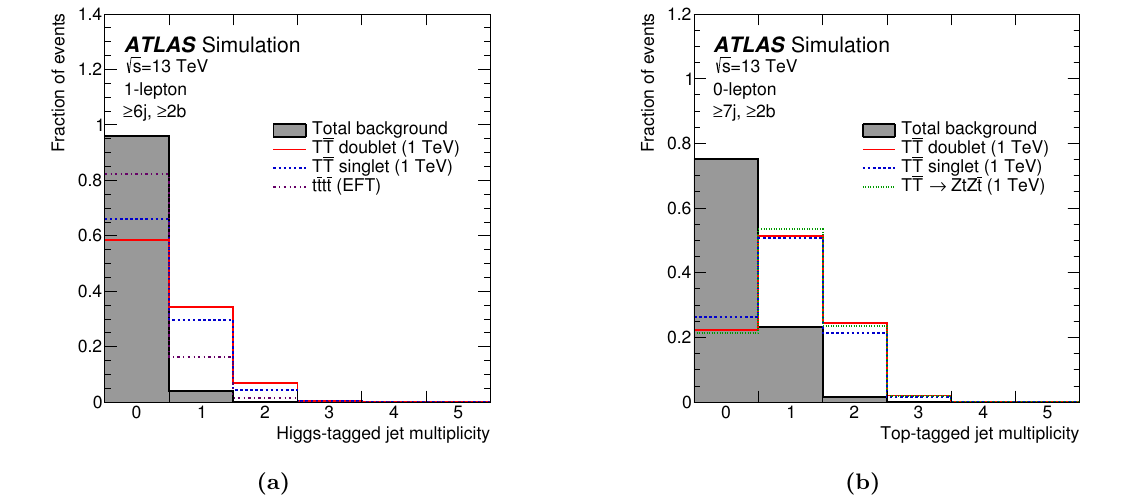
Figure 3. Comparison of the distribution of (a) the Higgs-tagged jet multiplicity and (b) the top-tagged jet multiplicity, between the total background (shaded histogram) and several signal scenarios considered in this search. The selection used in (a) corresponds to events in the 1-lepton channel satisfying the preselection requirements and 6 jets, whereas the selection used in (b) (cid:21) corresponds to events in the 0-lepton channel satisfying the preselection requirements and 7 jets. (cid:21) The signals shown correspond to: T (cid:22) T production in the weak-isospin doublet and singlet scenarios, and in the ( T Zt ) = 1 case, assuming m T = 1 TeV; and t (cid:22) tt (cid:22) t production within an EFT B !